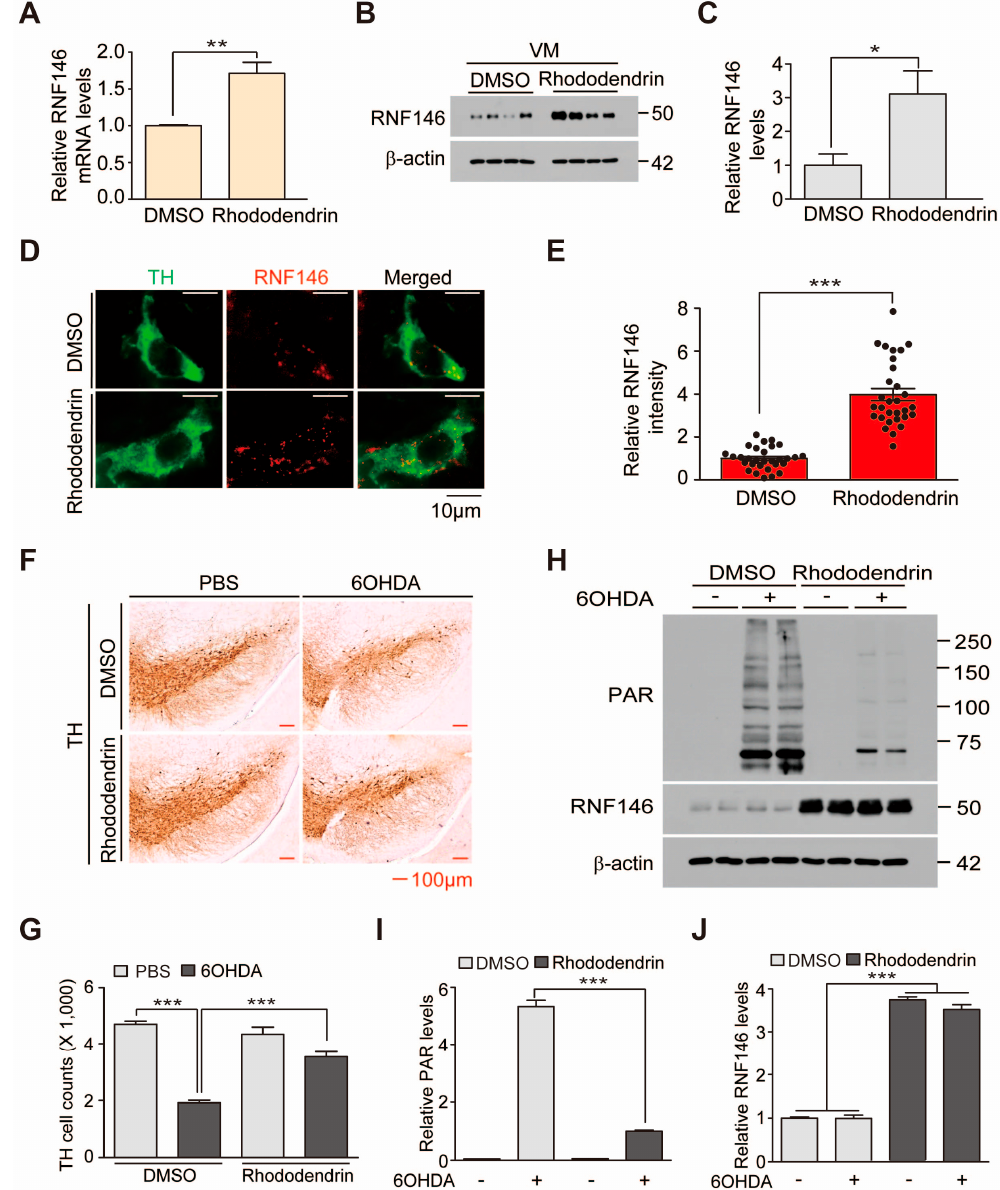
Figure 5. The RNF146 inducer rhododendrin prevents 6-OHDA induced dopaminergic cell death in vivo. ( A ) Quantification of relative RNF146 expression levels (normalized to those of GAPDH) in the ventral midbrain from mice treated with rhododendrin (i.p. 10 mg/kg/day, three days) as determined by RT-qPCR ( n = 4). ( B ) Western blot analysis of RNF146 expression in the ventral midbrain from three-month-old mice treated with rhododendrin (i.p. 10 mg/kg/day, three days) or DMSO vehicle. VM, ventral midbrain. ( C ) Quantification of RNF146 protein expression levels in ventral midbrain from three-month-old mice treated with rhododendrin or DMSO for three days. Values are normalized to those of β -actin ( n = four mice per group). ( D ) Representative confocal immunofluorescence images of TH (green) and RNF146 (red) expression using the indicated antibodies in ventral midbrain sections from three-month-old mice treated with rhododendrin or DMSO for three days. ( E ) Relative expression levels of RNF146 in TH-positive dopaminergic neurons in the rhododendrin-treated group as normalized to the DMSO group ( n = 30 cells per each group from three mice). ( F ) Representative tyrosine hydroxylase (TH) immunohistochemical staining of the substantia nigra of 6-OHDA PD